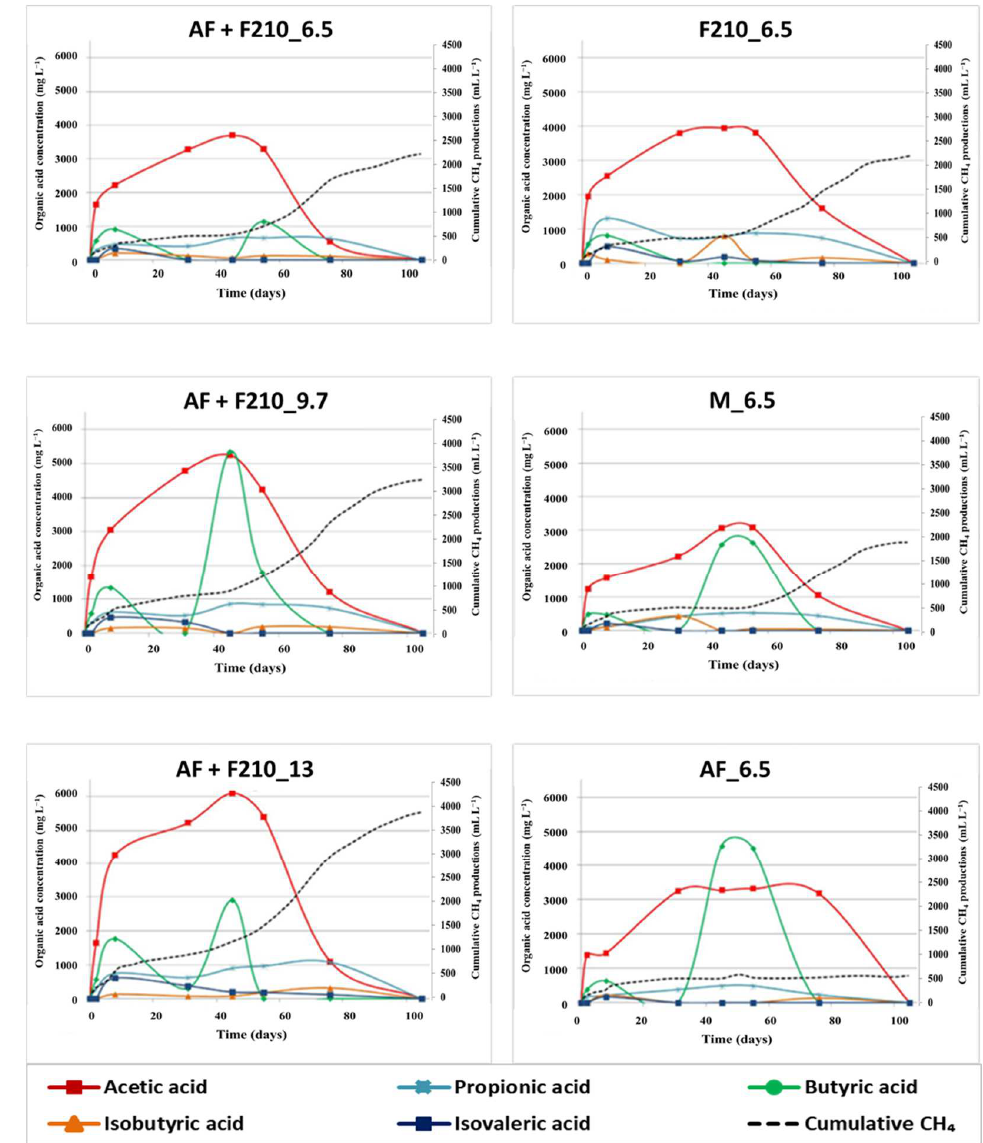
Figure 2. Organic acid concentration for combined bioaugmented tests at three SPW concentra- tions, i.e., AF + F210_6.5, AF + F210_9.7, and AF + F210_13 ( left column ) and single bioaugmenta- tion and un-augmented tests F210, M, AF ( right column